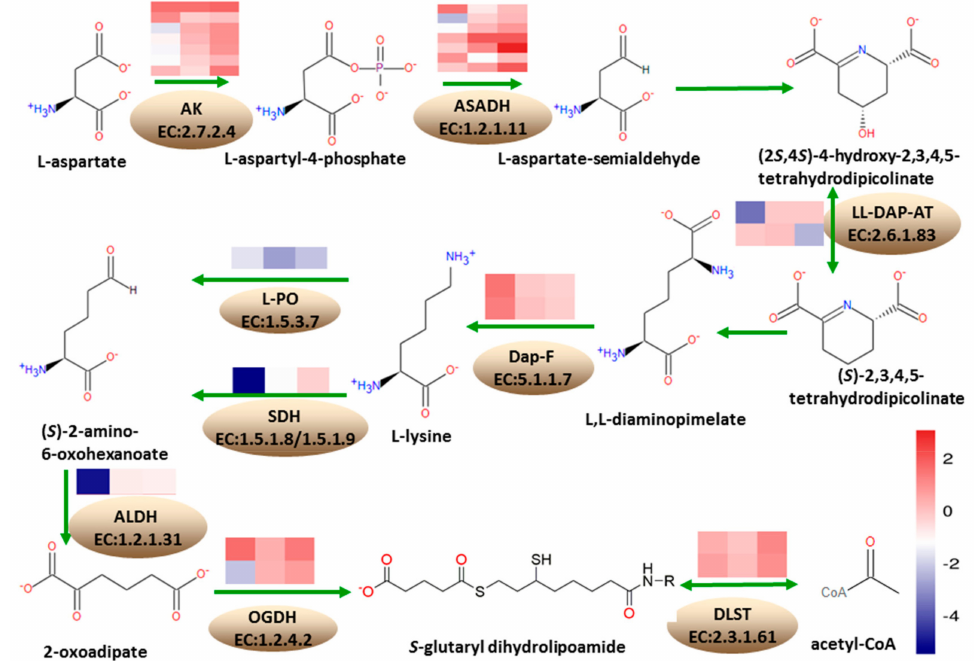
Figure 6. Expression of DEGs and their functions in lysine metabolism. Depths of color in the red and blue rectangles indicate higher and lower Z-score RNA expression lever. The columns on the heat map represent the stage (18 DAP, 28 DAP, and 38 DAP). The rows on the heat map represent the genes. Identified enzymes include: AK—aspartate kinase; ASDH—aspartate-semialdehyde dehydrogenase;